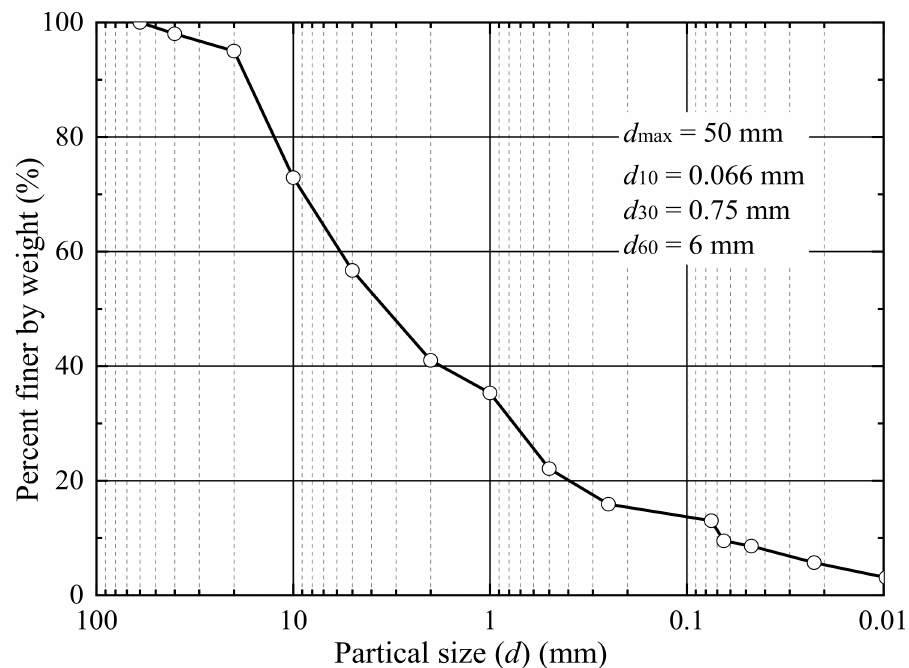
Figure 1. Particle size gradation curve of the UGM